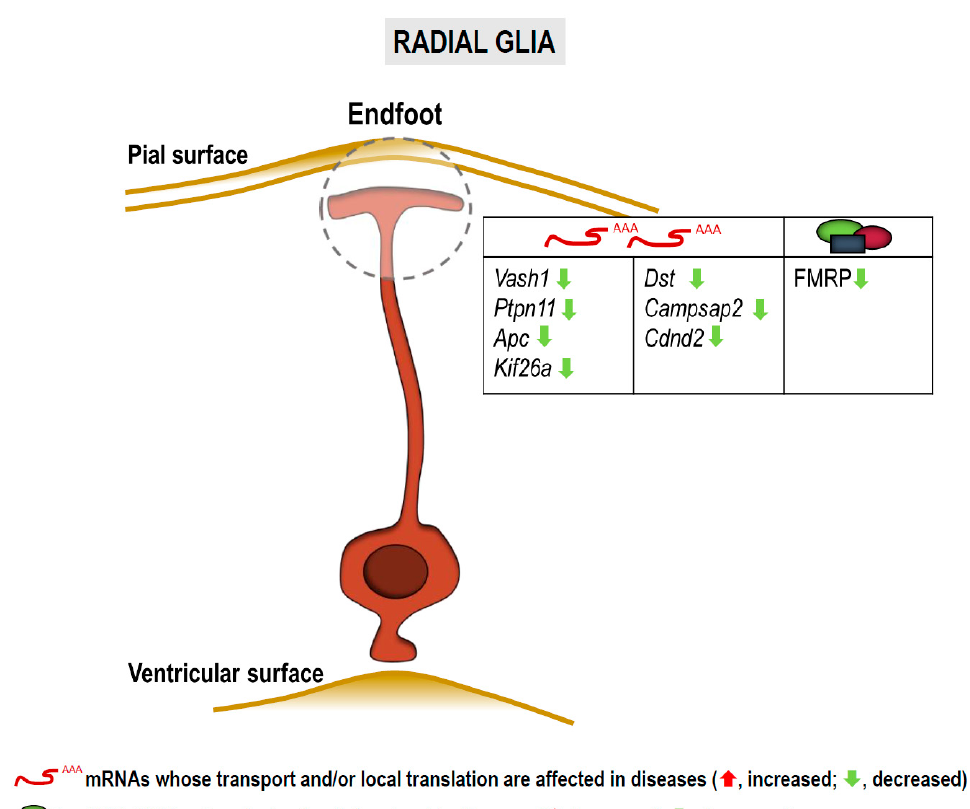
Figure 5. Transcripts and RBPs localized to subcellular compartments in radial glia potentially involved in neurological and neurodegenerative diseases. Arrows indicate altered levels (green, decrease) of mRNAs and/or proteins.